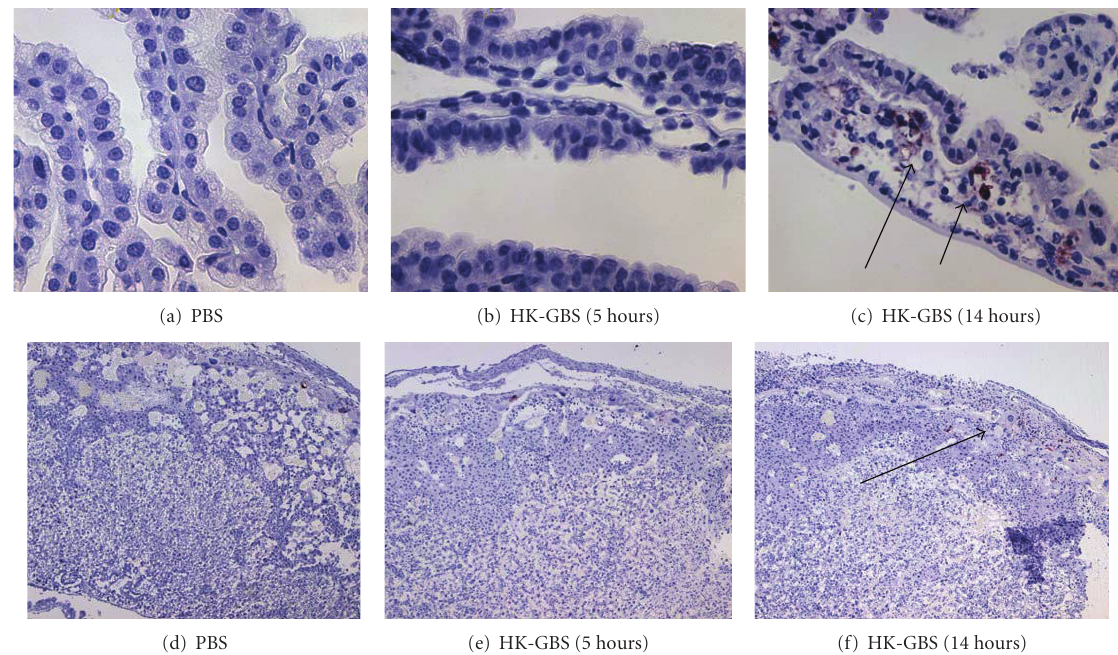
Figure 3: Intrauterine HK-GBS injection leads to caspase 3 activation in the membranes and placenta . Day 14.5 timed pregnant mice were injected with either PBS or HK-GBS and euthanized at 5 or 14 hours to isolate fetal membranes (a–c) and placentas (d–f). Caspase 3 activation was assessed by performing immunohistochemistry analysis using an antibody against active-cleaved caspase 3. Representative data from three separate experiments are shown. HK-GBS exposure led to an increase in caspase 3 positive cells in the membranes (c) and above the spongiform trophoblast layer at 14 hours in the placenta (f).